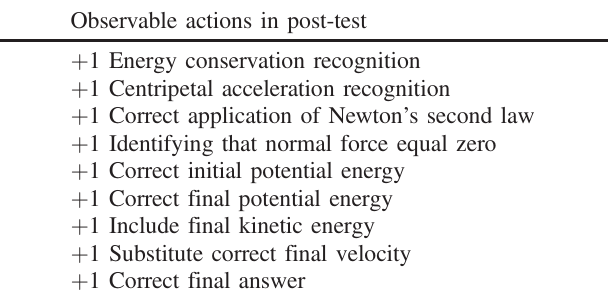
TABLE I. Scoring rubric for the problem-solving post-test [7]. Observable actions in